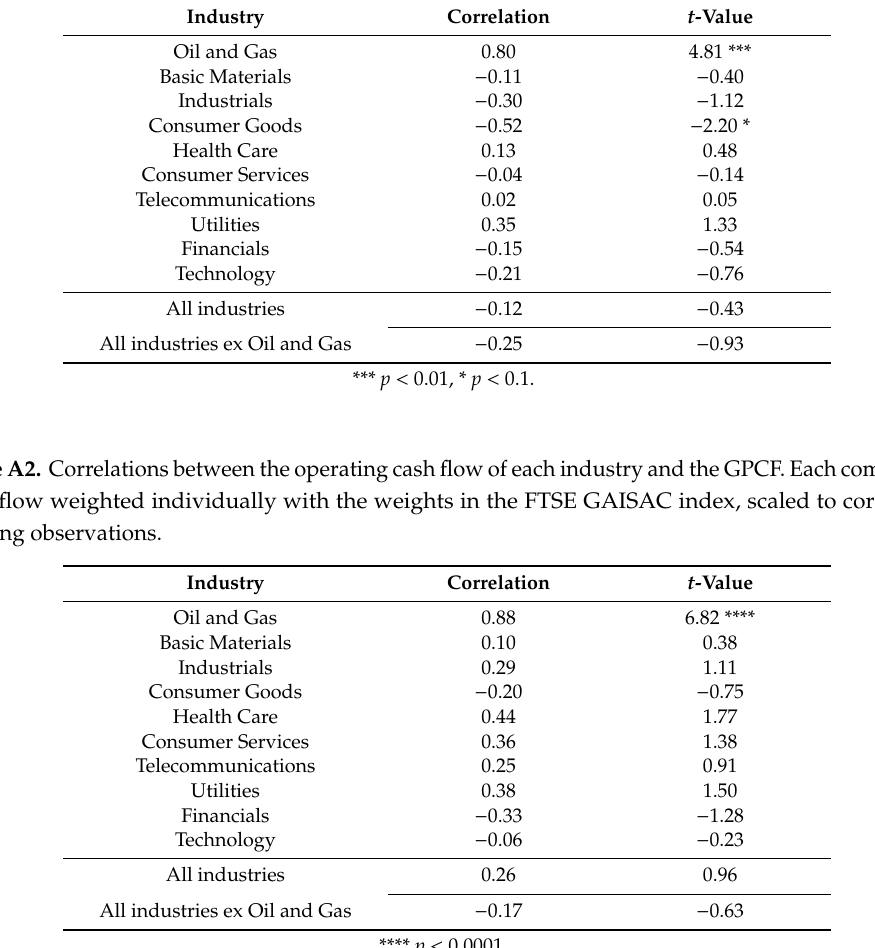
Table A1. Correlations between the operating cash flow of each industry and the GPCF. Industry cash flow weighted with FTSE GEISAC industry weights. All correlations on first-di ff erence data 2004–2018.